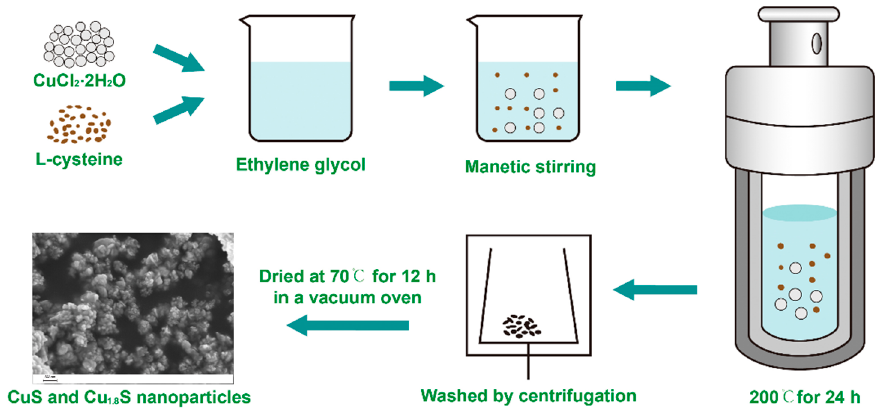
Figure 1. The schematic illustration of the preparation of CuS/Cu 1.8 S nanocomposites.